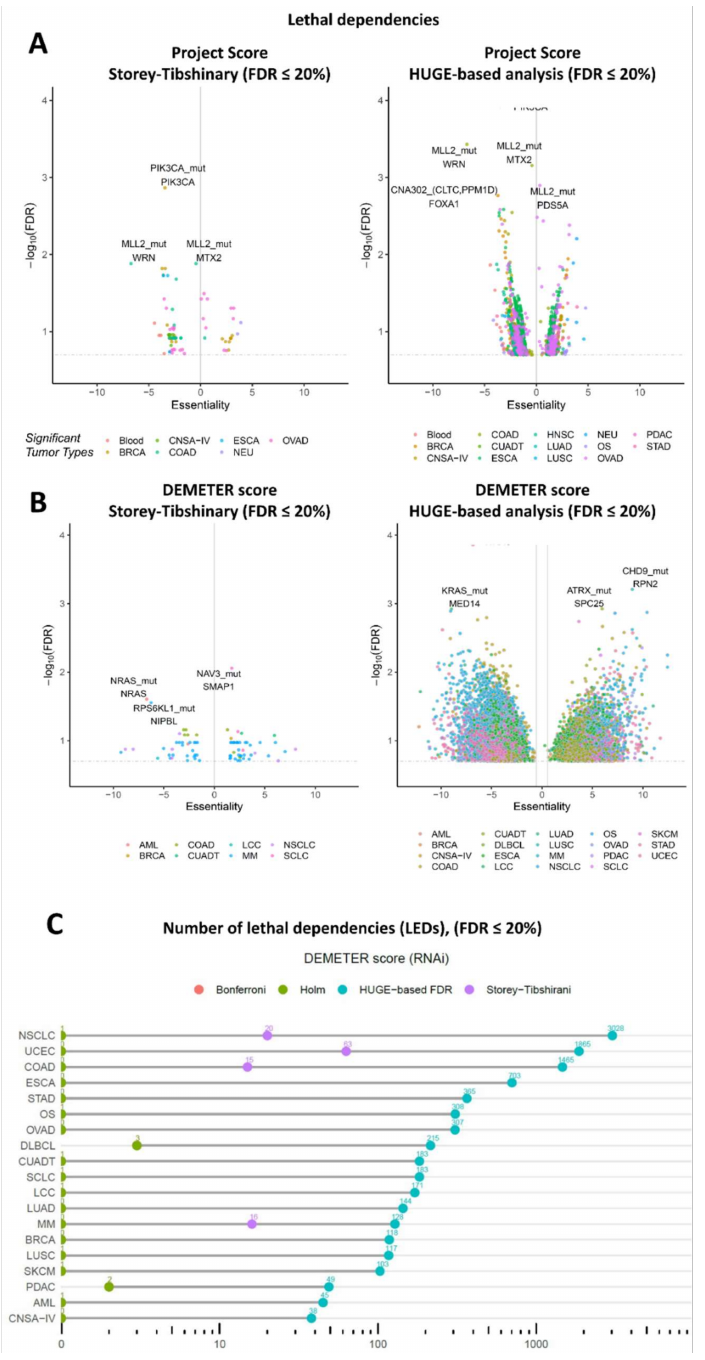
Figure 2. HUGE-based analysis with Project Score and Achilles Project datasets. ( A ) Volcano plots of lethal dependencies, LEDs, identified in the Project Score dataset. From left to right: (i) result